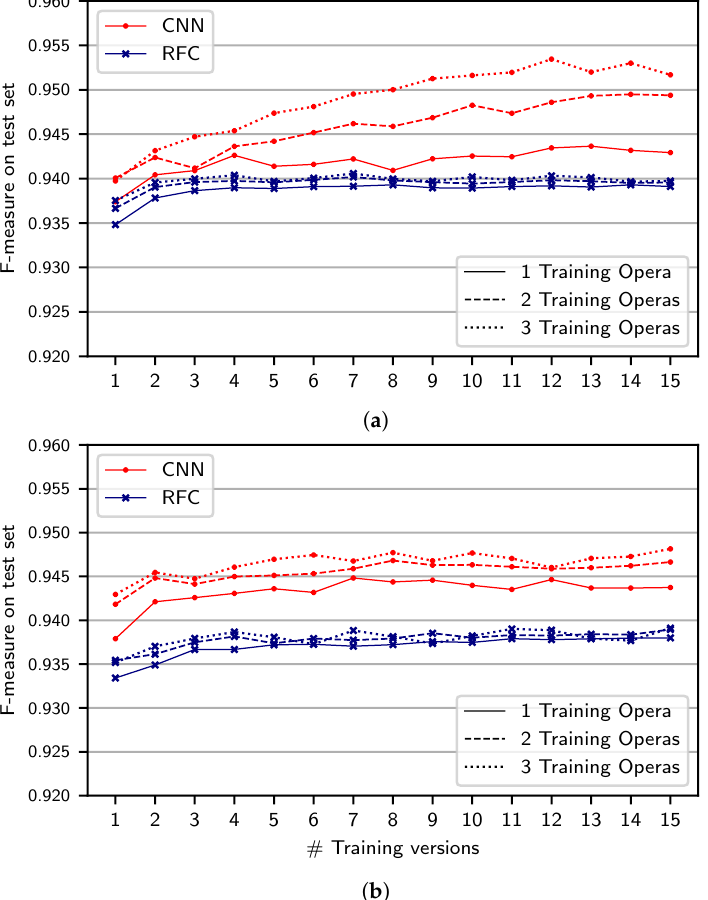
Figure 7. Results for both systems when training on varying numbers of versions and operas (solid, dashed, and dotted curves) that are different from the test version and act ( neither split ). ( a ) Using the full data for training. ( b ) Using sub-sampling of the training datasets to the same